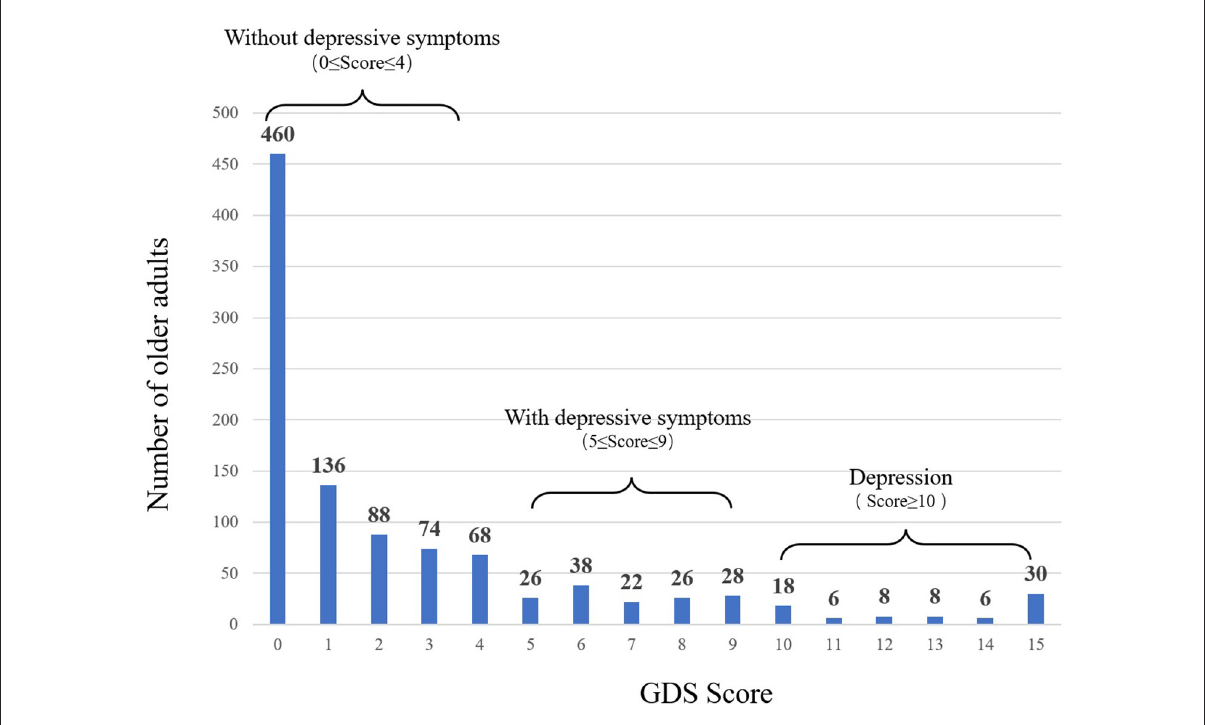
FIGURE2 Depressive situation of older